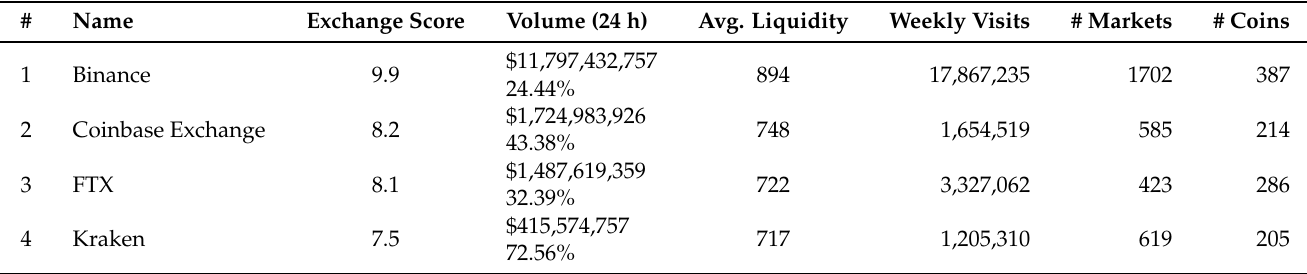
Table A14. Top ten cryptocurrency exchanges ranked by volume CoinMarketCap (2022) https: //coinmarketcap.com/rankings/exchanges/, accessed on 29 August